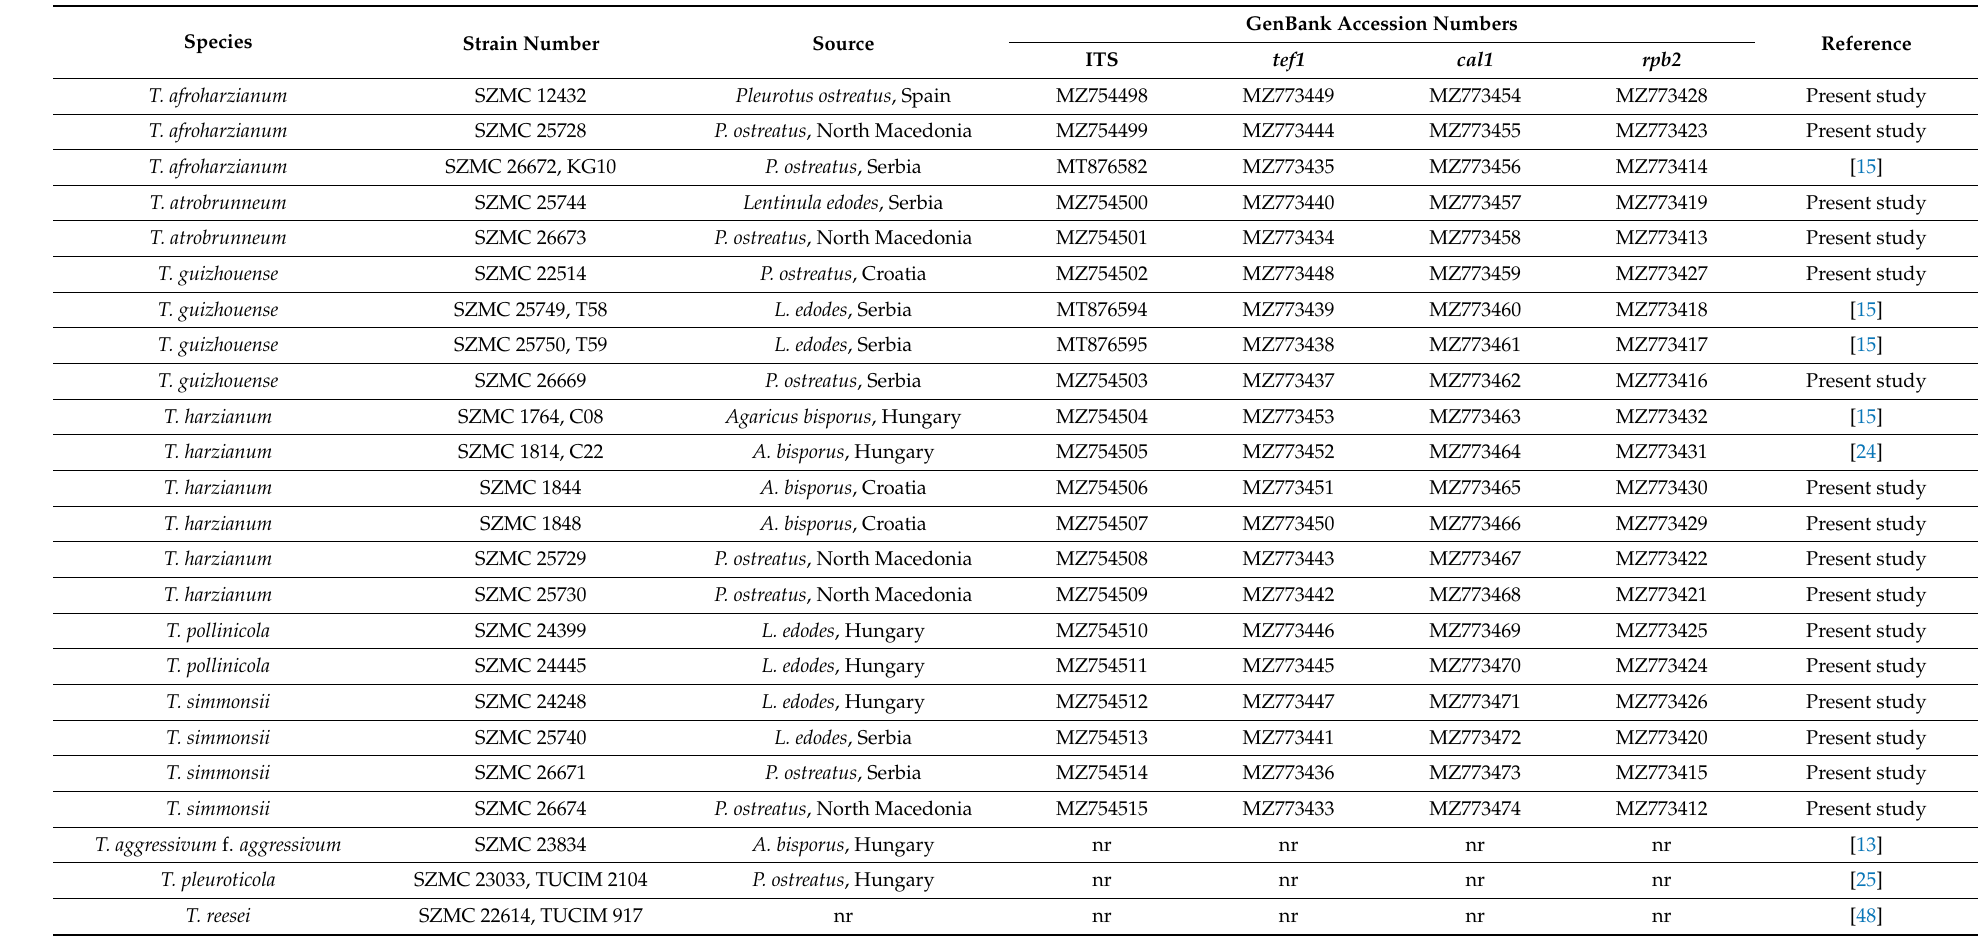
Table 1. Trichoderma strains examined in the